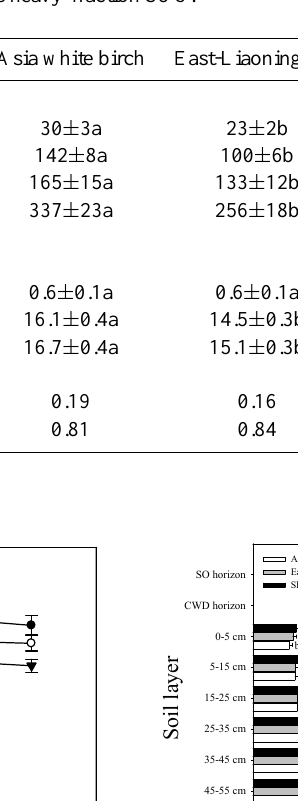
Table 2. Soil organic carbon inputs and pools in Asia white birch and East-Liaoning oak forests of warm temperate zone and Sharptooth oak forest of sub-topical zone. Values represent mean ± standard error (inputs in gCm − 2 yr − 1 ; pools in kgCm − 2 ; n =5). Different letters in each row are significantly different at P < 0.05. Labile carbon was assumed to include non-woody surface litter and light-fraction SOC. Recalcitrant carbon was estimated as woody debris plus heavy-fraction SOC.